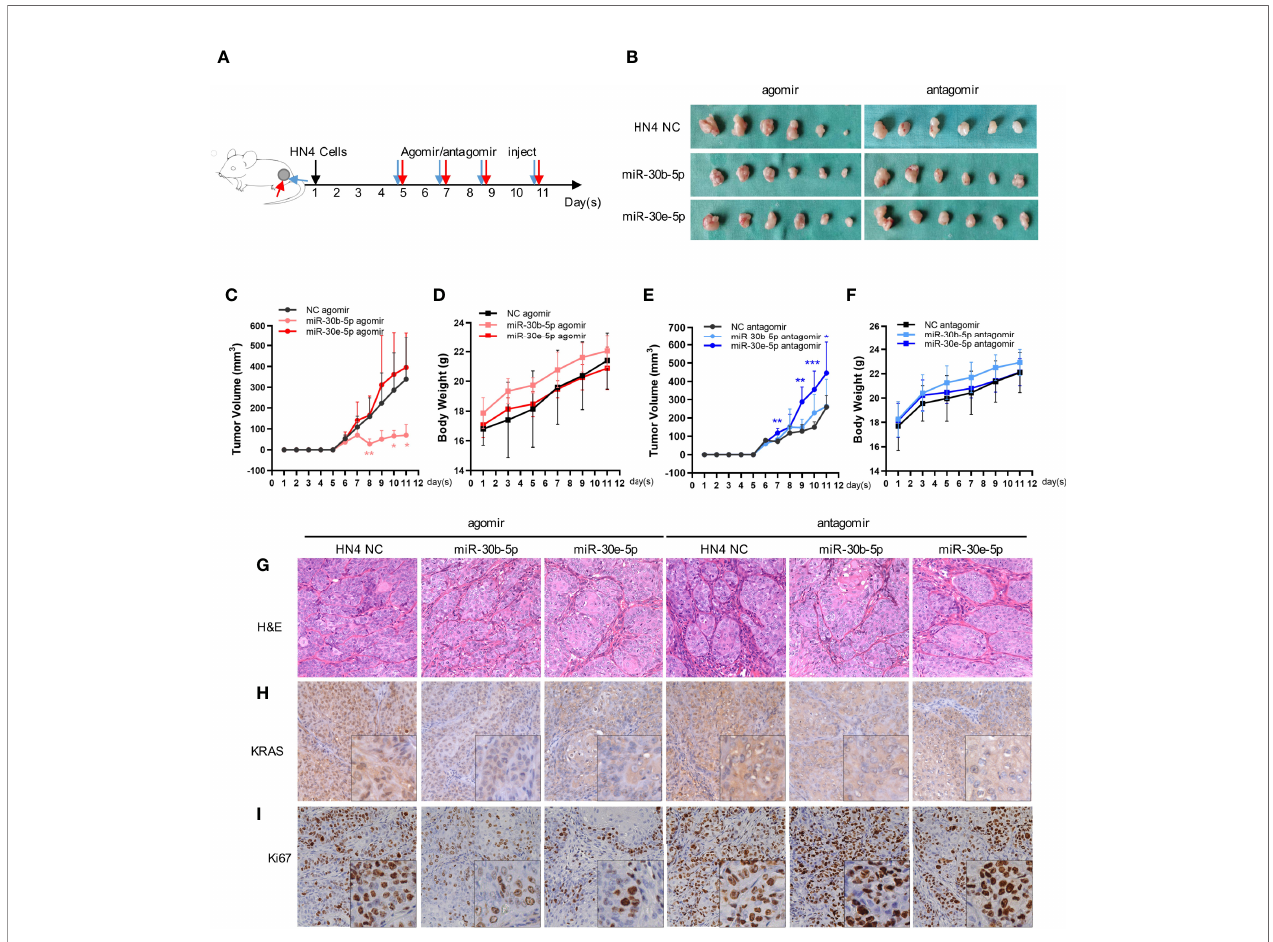
FIGURE 6 | The tumor growth might be suppressed by miR-30b-5p or miR-30e-5p. (A) Injection protocols of the miR-30b-5p or miR-30e-5p for subcutaneous tumorigenesis in nude mice. (B) Macro images of subcutaneous tumors. (C, E) The volume of subcutaneous tumors in nude mice. (D, F) The body weight of tumorigenesis nude mice. (G) Representative images of H&E staining of subcutaneous tumors injected with different miRNAs (400×). (H, I) The expression of KRAS or Ki67 in subcutaneous injected with different miRNAs (400×). (** p <0.01, *** p